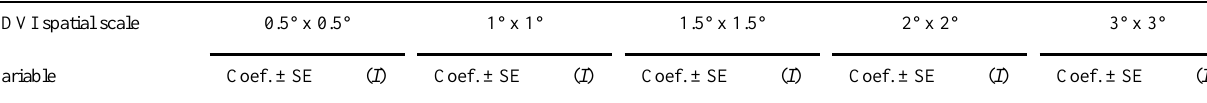
Table 1. Regression models of Common House-Martin and Common Swift population indices obtained by Bayesian model